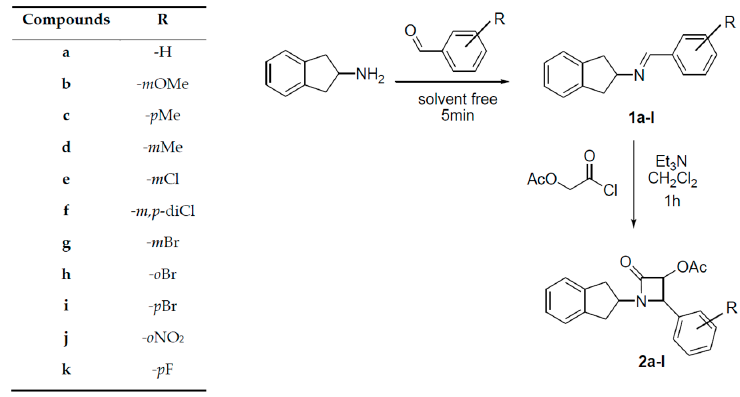
Figure 1. General synthesis route of novel β -lactam derivatives ( 2a – k ).